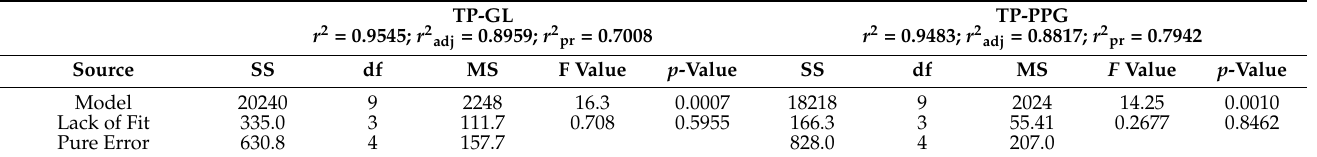
Table 4. Analysis of variance (ANOVA) for the fitted model quadratic polynomial